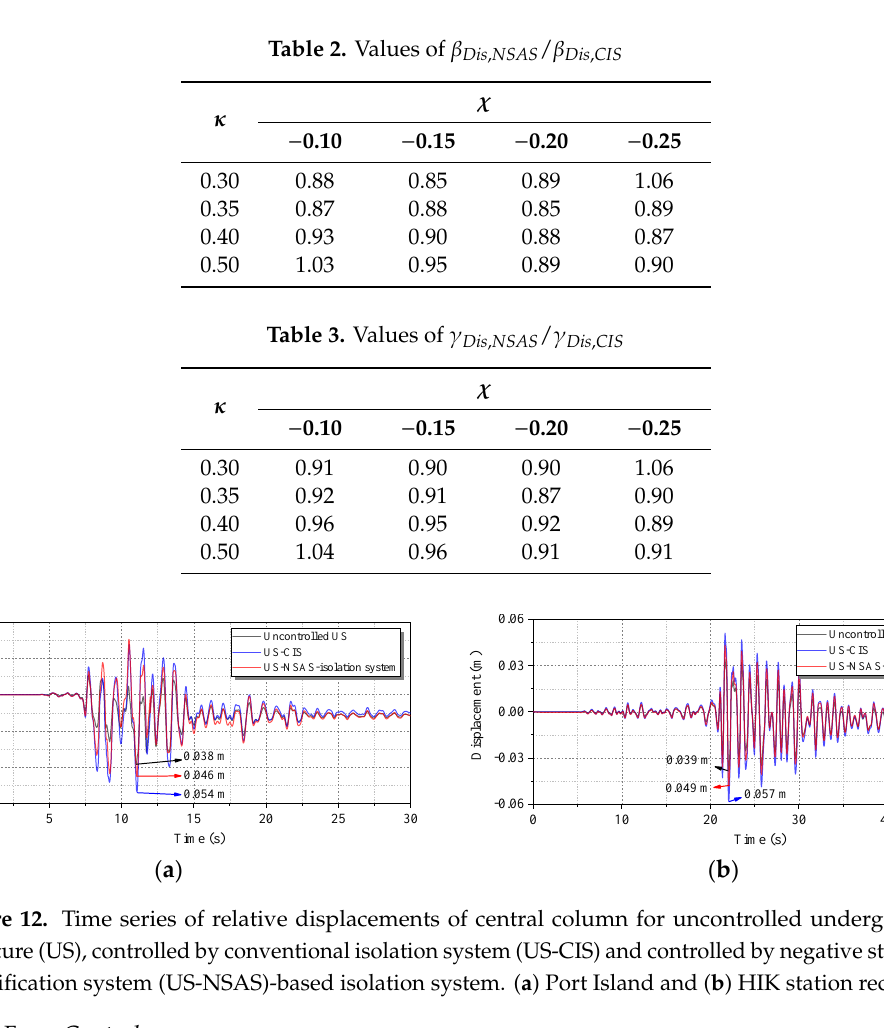
Table 3. Values of 